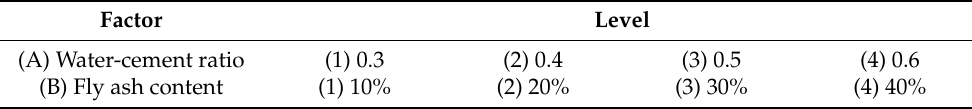
Figure 1. The preparation process of foam concrete. Table 5. Orthogonal test factors and levels of foam